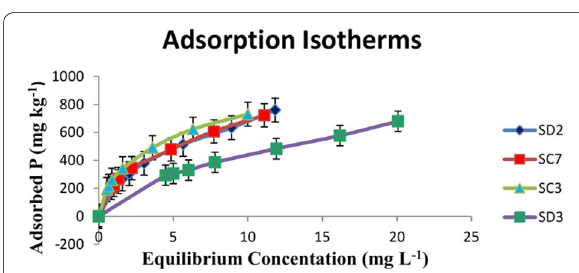
Fig. 4 Adsorption Isotherms of SD2, SC7, SC3 and SD3 soils